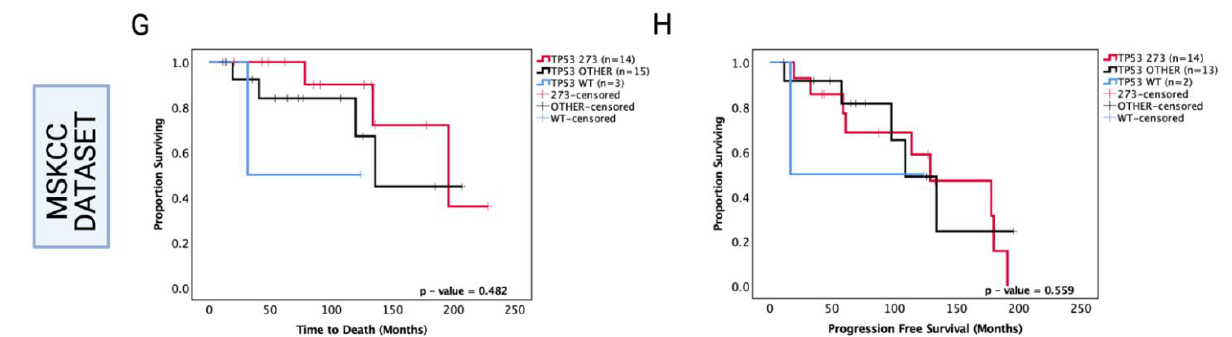
Figure 6. Kaplan–Meier survival curves comparing effects of TP53 mutation status in the prognosis of chemotherapy-treated and no-chemotherapy groups. OS and PFS of chemotherapy-treated groups in our cohort ( A , B ) and the MSKCC cohort ( C , D ). OS and PFS of no-chemotherapy groups in our cohort ( E , F ), and the MSKCC cohort ( G , H ). TP53 273: TP53 codon 273 mutant, TP53 OTHER: all pathogenic TP53 mutations except in codon 273, TP53 WT: wild-type TP53 status. Log-rank test was used for analysis and a p -value < 0.05 for statistical